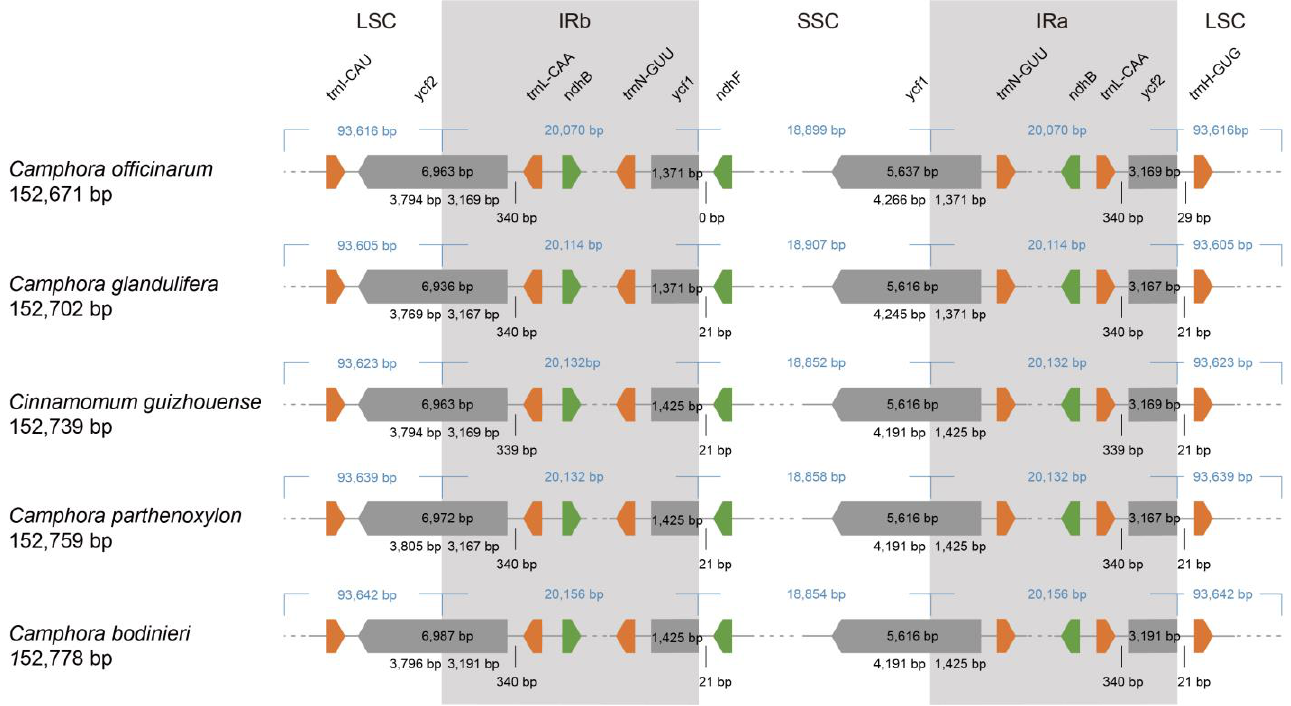
Figure 5. Contraction and expansion of IRs in the plastome of Cinnamomum guizhouense C.Y. Deng et al. compared with four plastomes of Camphora Fabr.. Genes and their relative positions were not drawn to scale.